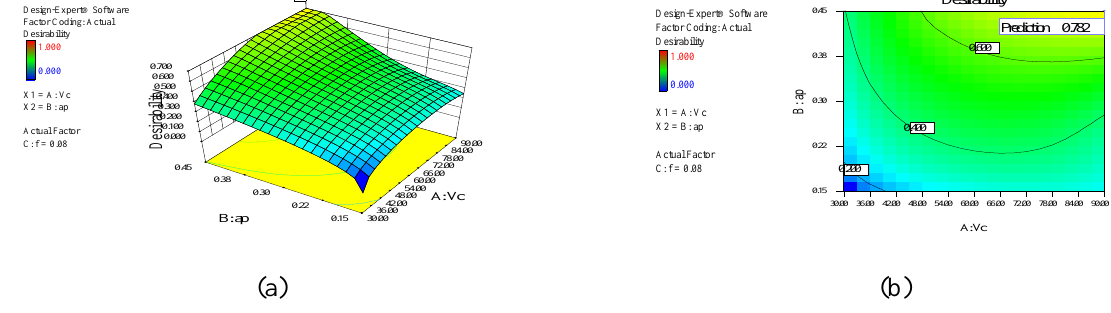
Fig. 21. 3D surface plot (a) and contour plot (b) for Desirability case (2)